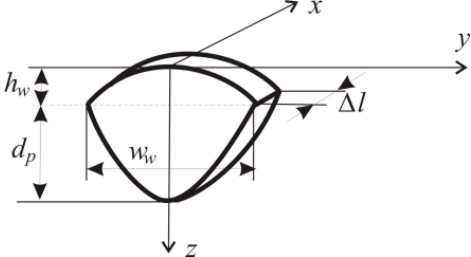
Figure 2. Geometry of the weld: h w —height of the weld, w w —width of the weld, d p —depth of filling.